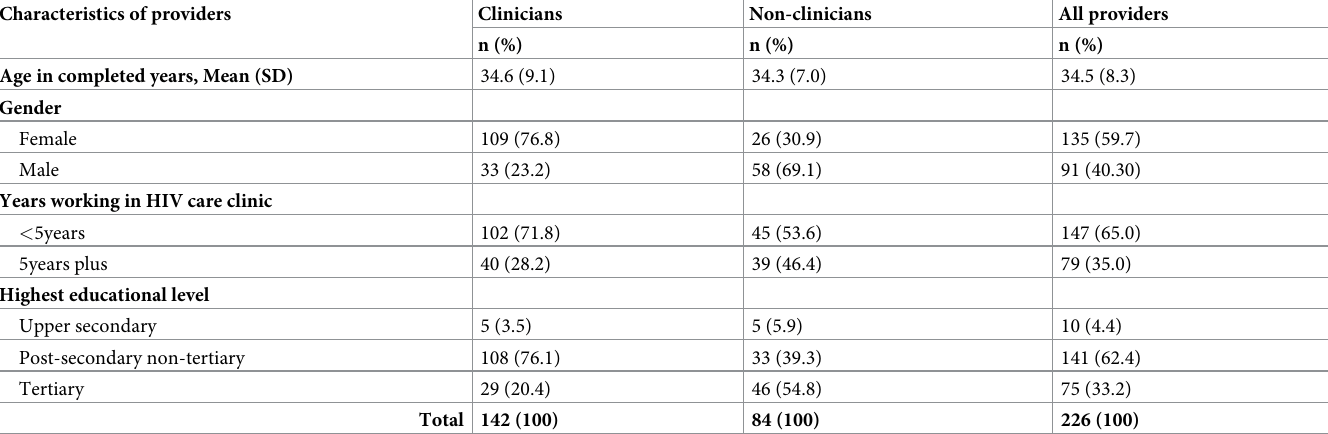
Table 2. Characteristics of the healthcare providers by profession at the HIV clinics in Ghana, 2019. Characteristics of